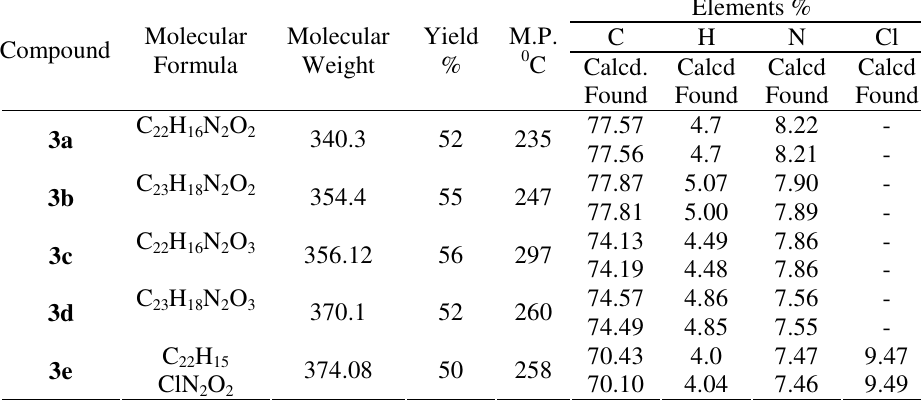
Table 2 . Physical data of the synthesized